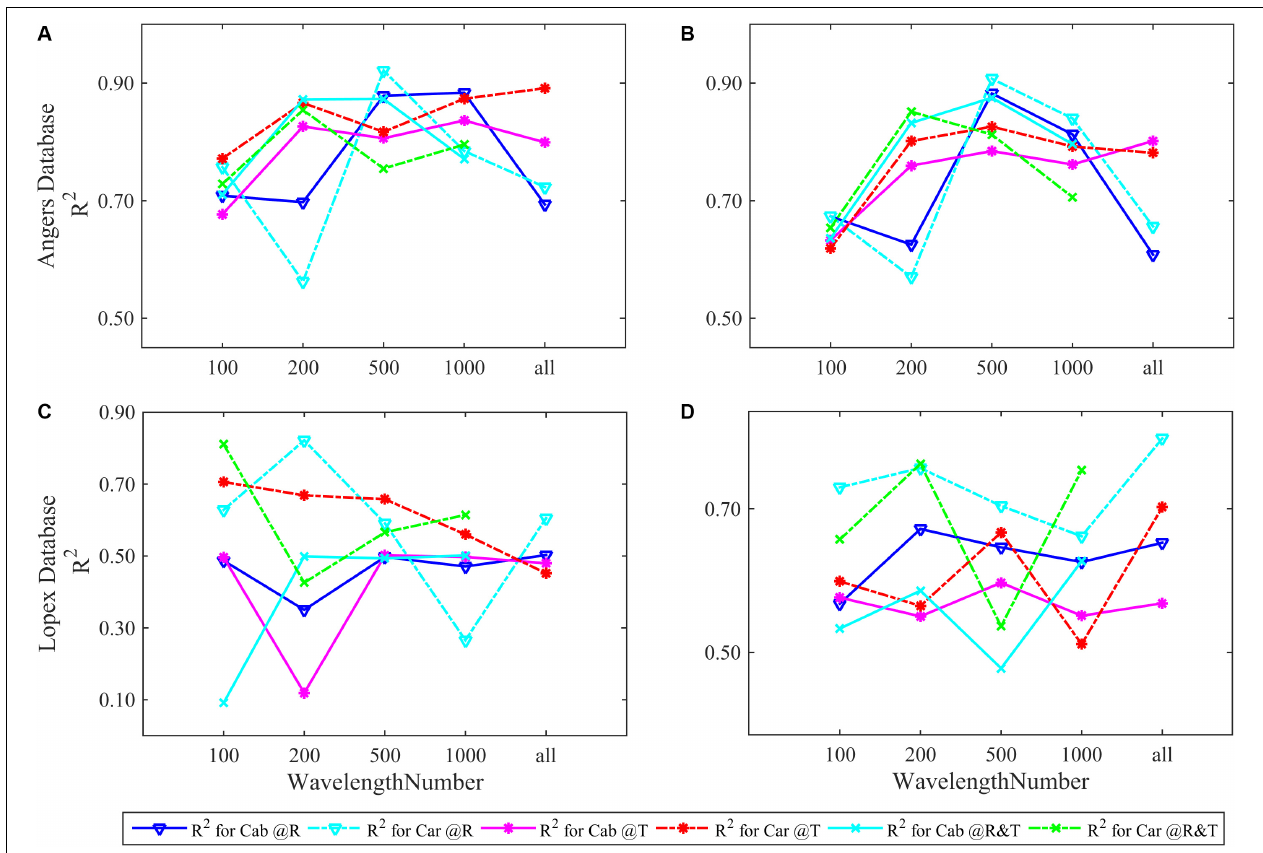
FIGURE 3 | The R 2 of FW-ANNs models for Cab and Car analysis using different numbers of R, T, and R&T spectral bands based on the ANGERS and LOPEX databases. Subpanels (A) , (C) show the R 2 of separately inverting four parameters and (B) , (D) is that combining them as a whole of dependent variable for FW-ANNs analysis. The optimal train function of FW-ANN model is